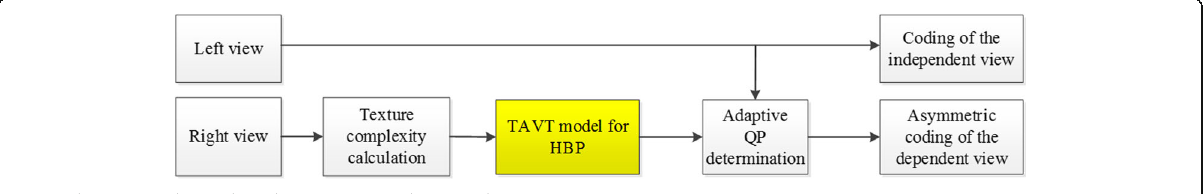
Fig. 9 The proposed TAVT-based stereoscopic video encoder